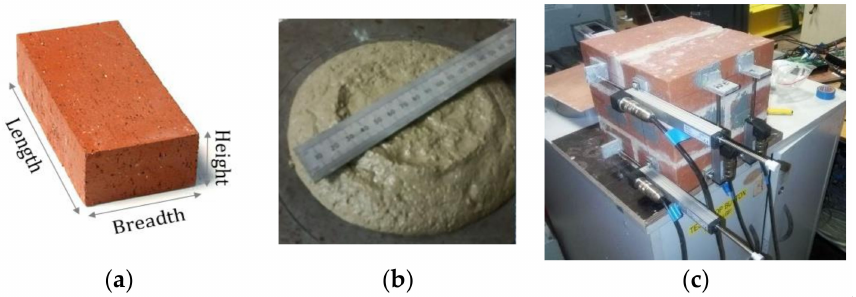
Figure 3. Material characterisation specimens: ( a ) brick unit, ( b ) mortar and ( c ) masonry cubic